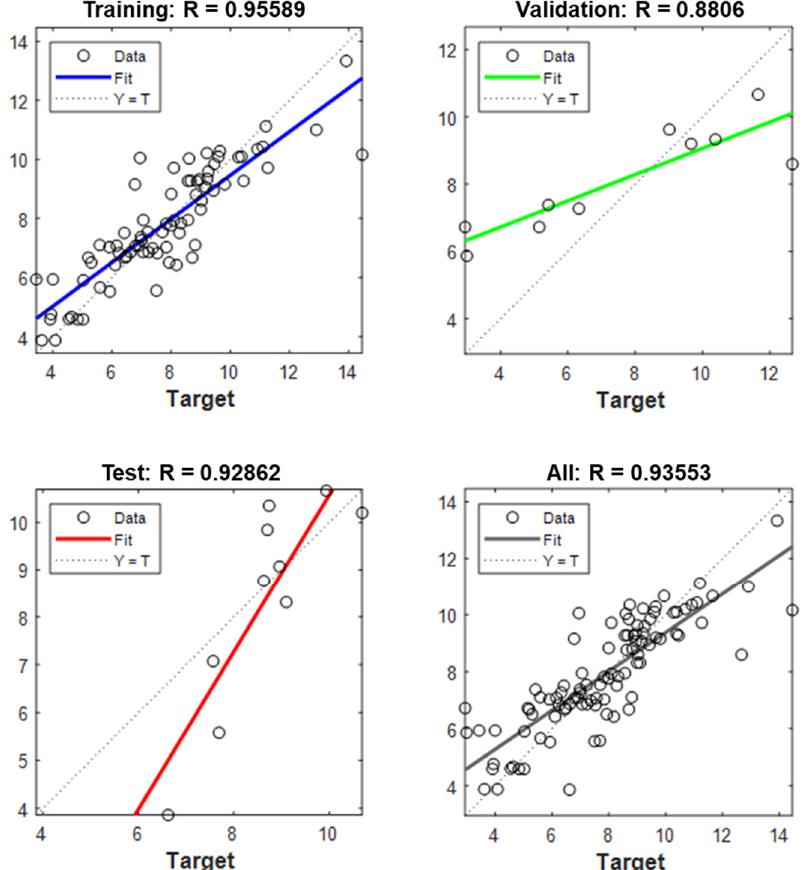
Figure 6. Neural Network Model R 2 values for test, training, validation, and all data. Table 4. Curvature comparison based on the prediction model and the experimental